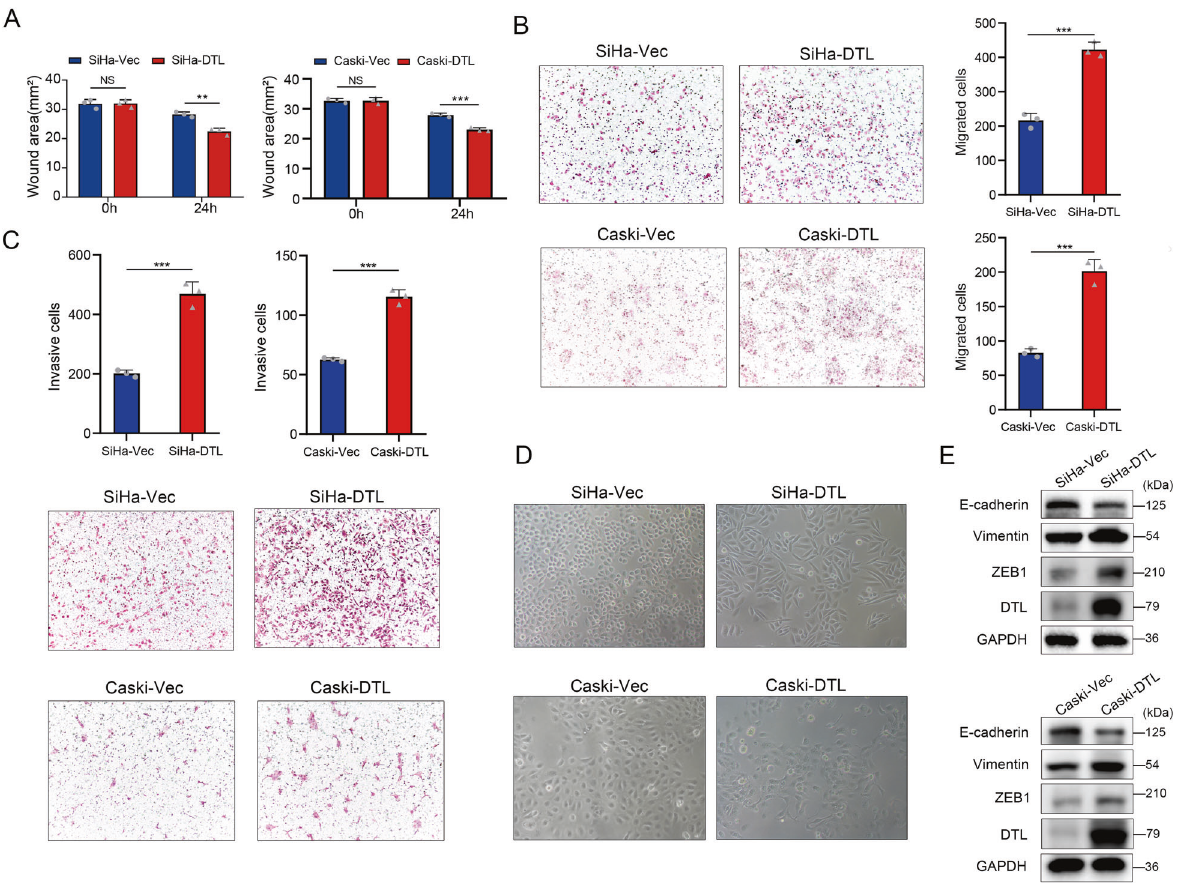
Fig. 2 DTL enhanced tumor cell migration and invasion in vitro and induced EMT. A Wound-healing assay showing that DTL overexpression enhanced the migration of SiHa and Caski cells. B , C Transwell assays indicating that DTL overexpression stimulated cell migration ( B ) and invasion ( C ) in SiHa and Caski cells. D , E Cell images were taken after stably expressing vector or DTL ( D ) and western blotting was performed ( E ). Error bars indicate the mean ± SD of three independent experiments. Student ’ s t -test; * P < 0.05, ** P < 0.01, *** P <